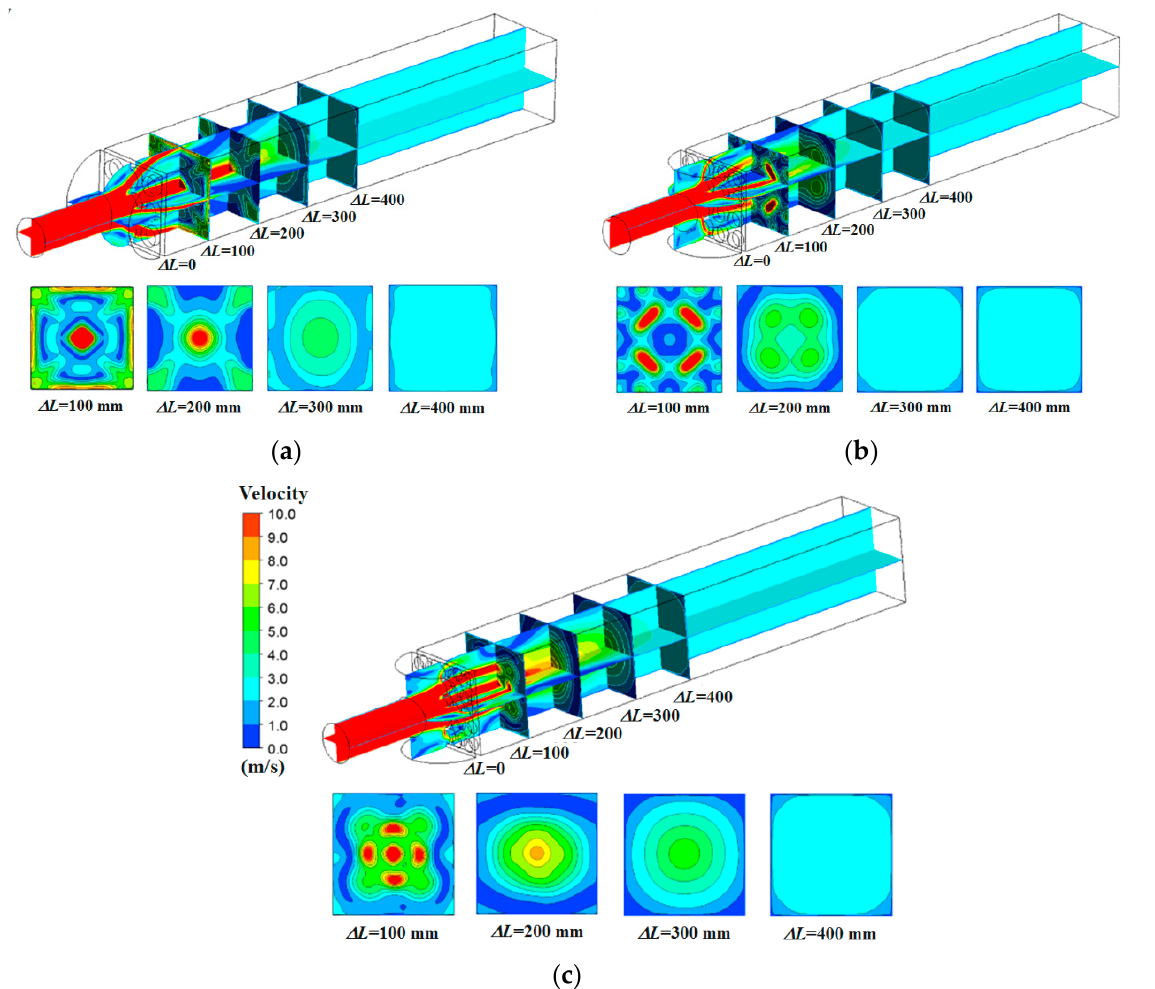
Figure 10. Flow distributions in entrance heads with three types of SPBs and their four cross-sections, ( a ) 3 × 3 SPB, ( b ) 4 × 4 SPB, ( c ) 5 × 5 SPB.